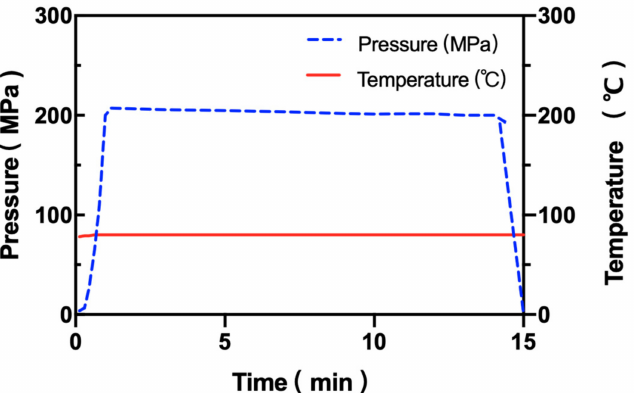
Figure 1. Pressure and sample temperature for a 200 MPa, 80 ◦ C treatment with a 15 min pressure dwell